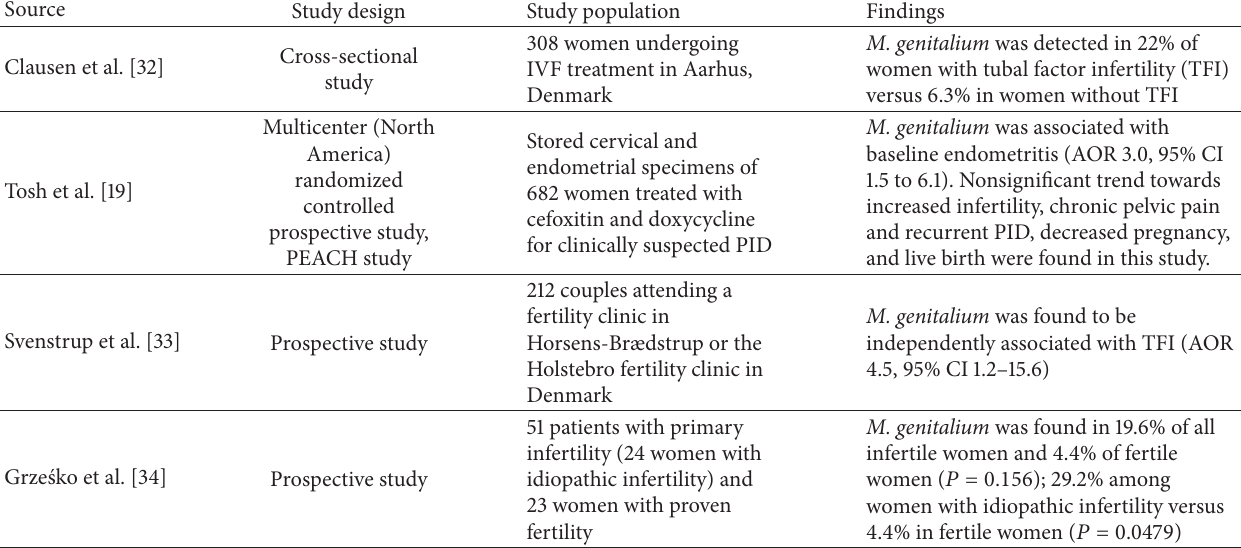
Table 2: Summary of studies regarding M. genitalium and female